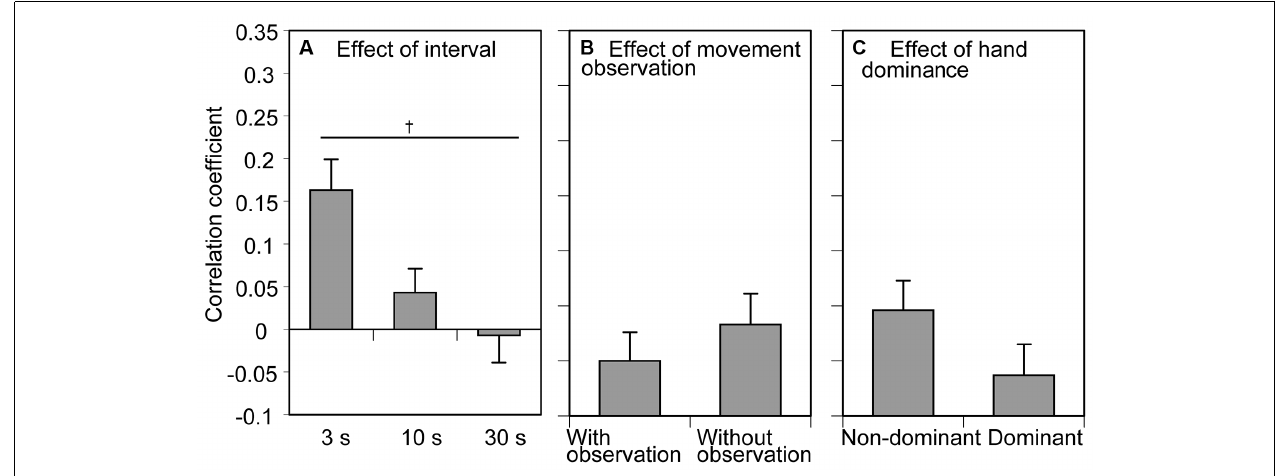
FIGURE 4 | The correlation coefficient of the reaction time (RT) between the previous and current movement trials. Bars show the mean and error bars are the standard error of the mean. The correlation coefficient averaged across the conditions of movement observation and hand dominance to show the effect of the inter-trial interval is presented in (A) . The correlation coefficient averaged across the conditions of inter-trial interval and tested side to show the effect of movement observation is presented in (B) . The correlation coefficient averaged across the conditions of inter-trial interval and movement observation to show the effect of hand dominance is presented in (C) . A dagger indicates a significant difference between the inter-trial intervals ( p < 0.05, Bonferroni’s test).